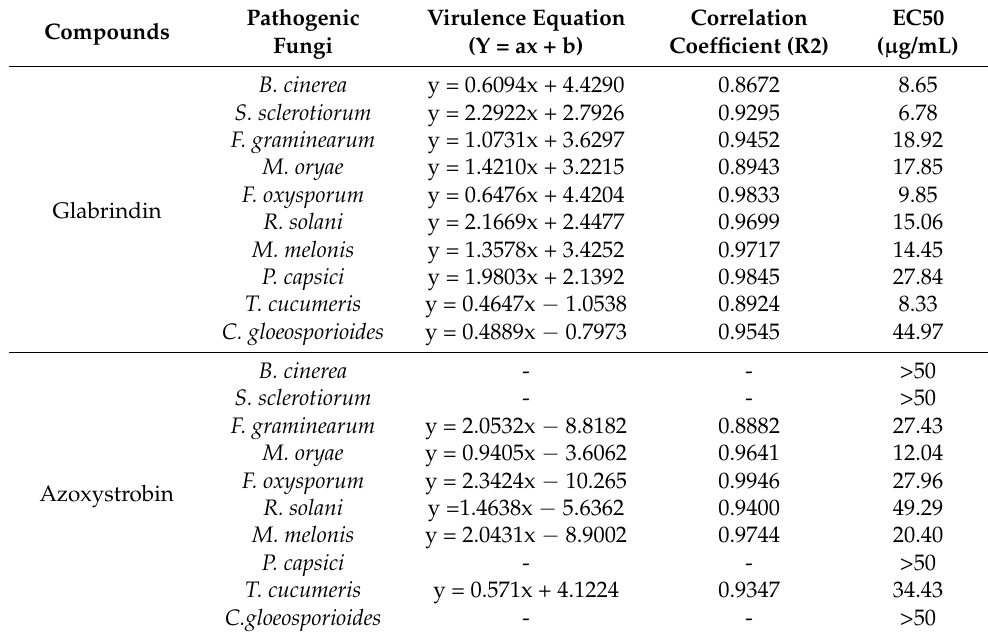
Data are displayed as mean ± SD. NA = no activity. Table 2. In vitro fungicidal activity of glabridin against ten plant pathogenic fungi.